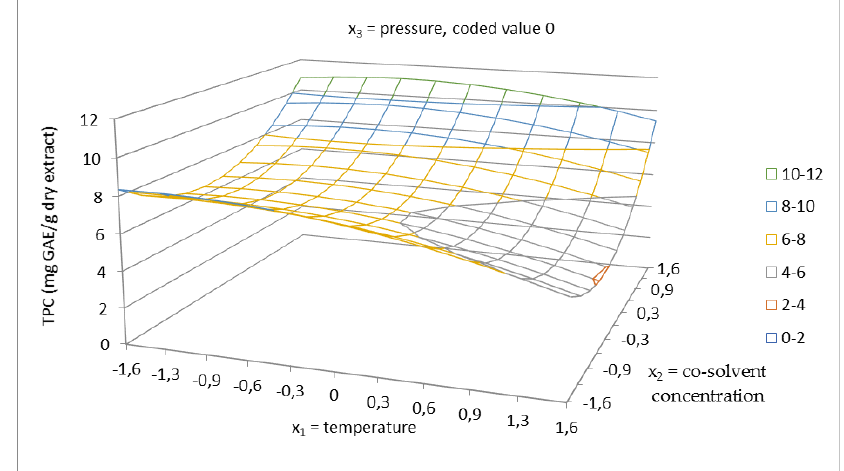
Figure 6. Response surface of total phenolics content as a function of temperature in the range of 40– 100 °C and EtOH/water cosolvent concentration of 40–96.6% in coded values at constant pressure of 5025 psi (coded value 0). Molecules 2019 , 24 , x FOR PEER REVIEW